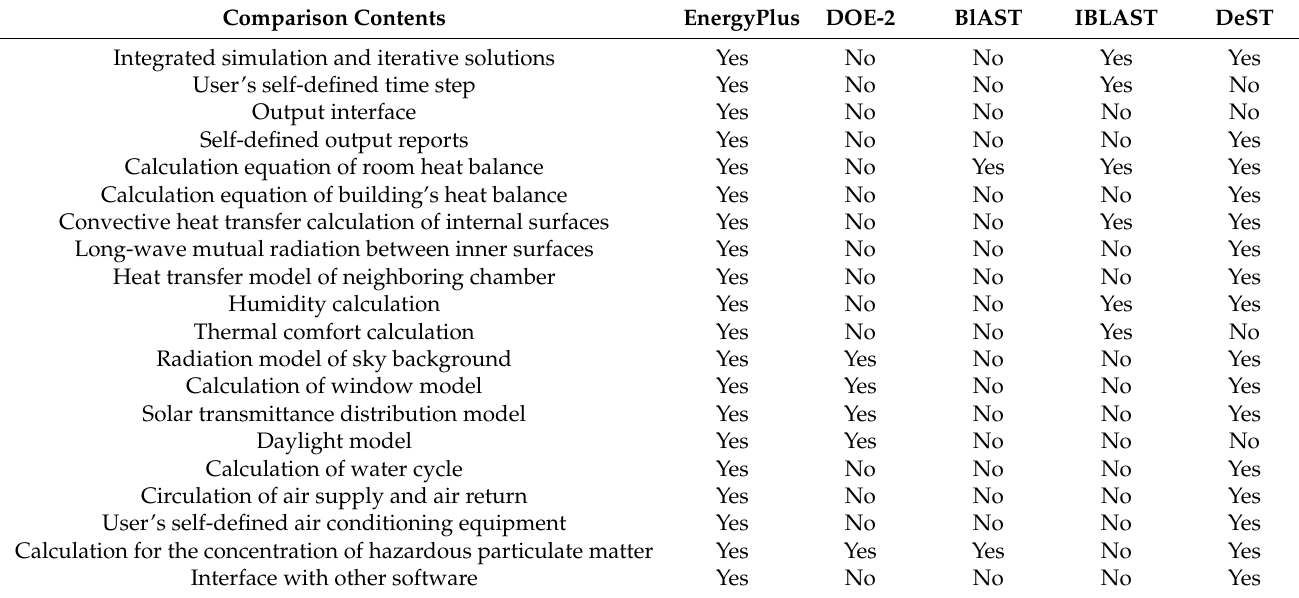
Figure 7. Operation logic of EnergyPlus simulation. Table 6. Comparison of EnergyPlus with other